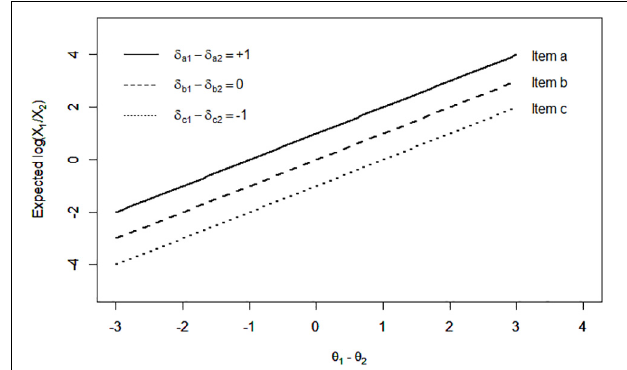
FIGURE 2 | Expected log ratio of X 1 to X 2 across different levels of θ 1 – θ 2 and δ 1 – δ 2 in the